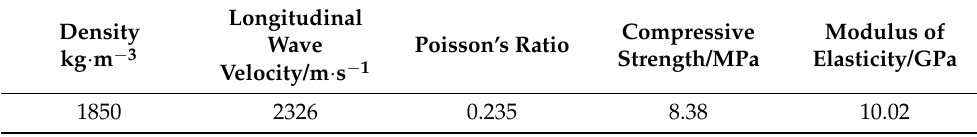
Table 2. Physical and mechanical parameters of